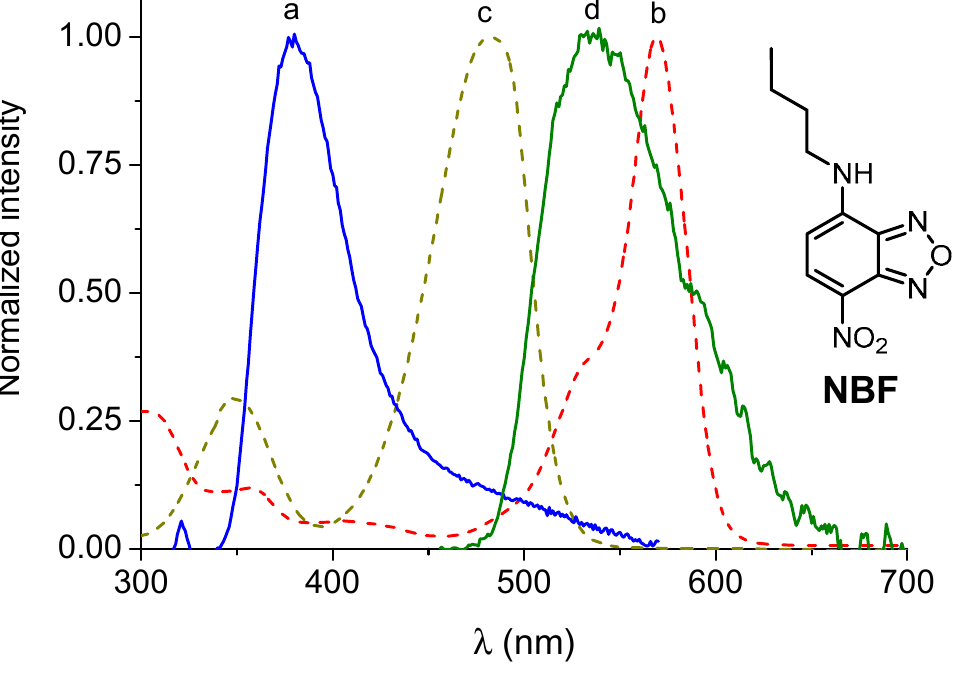
Figure 5. Normalized fluorescence spectra of LVB (a) ( λ exc = 240 nm), NBF (d) ( λ exc = 440 nm), and absorption spectra of NBF (c) and RD-NO (b). All guests are loaded in PolyCD (2 mg mL − 1 ) dissolved in PBS (pH 7.4). T = 25 °C.